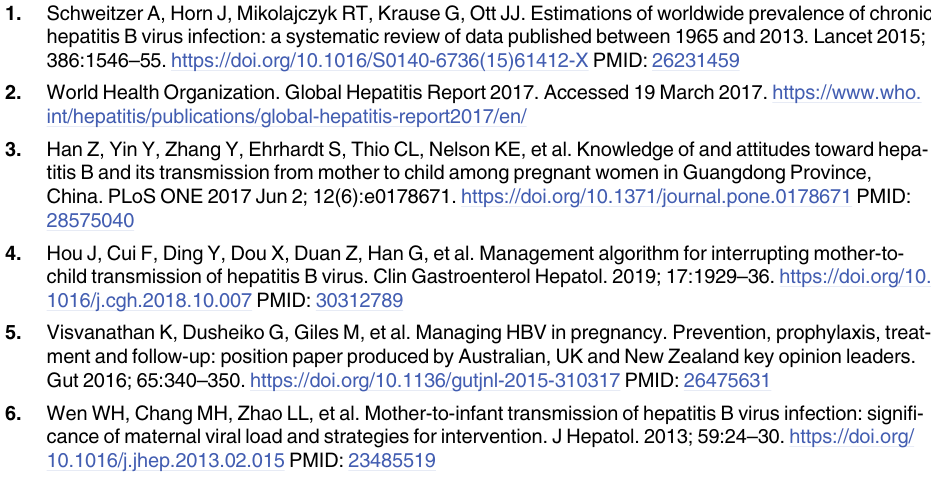
S1 Fig. Changes from baseline in estimated Glomerular Filtration Rate (eGFR) by the Cockcroft-Gault method. SD, standard deviation; TAF, tenofovir alafenamide; TDF, tenofo- vir disoproxil fumarate. � p < 0.05, †p <